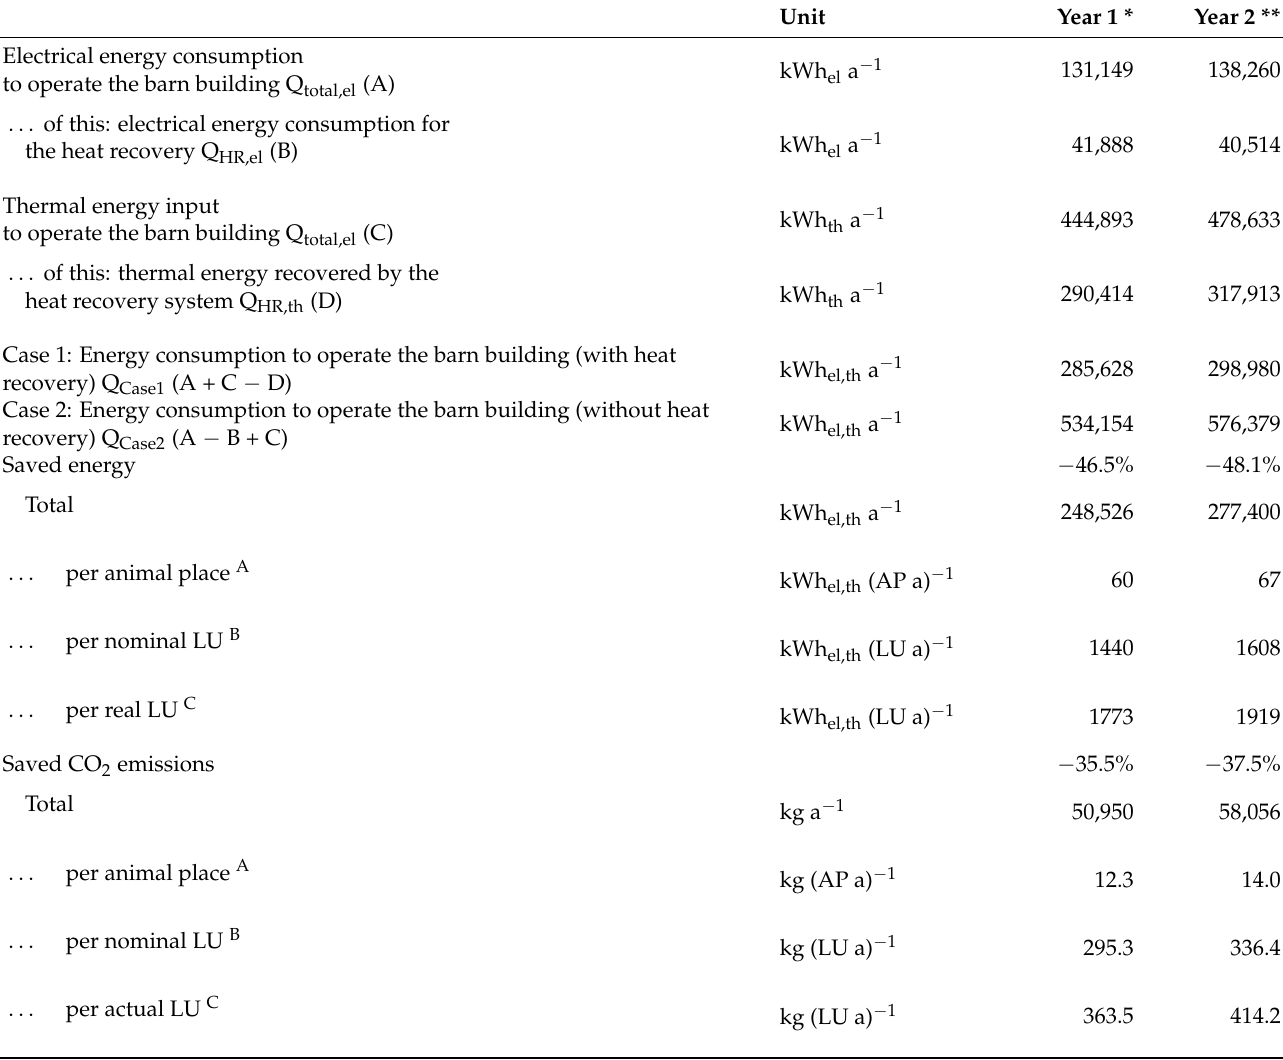
Table 3. Total energy consumption operating the piglet rearing barn during the trial period in Case 1 (with heat recovery) and Case 2 (without heat recovery), and the corresponding savings of energy consumption, CO 2 emissions, and energy costs using the heat recovery